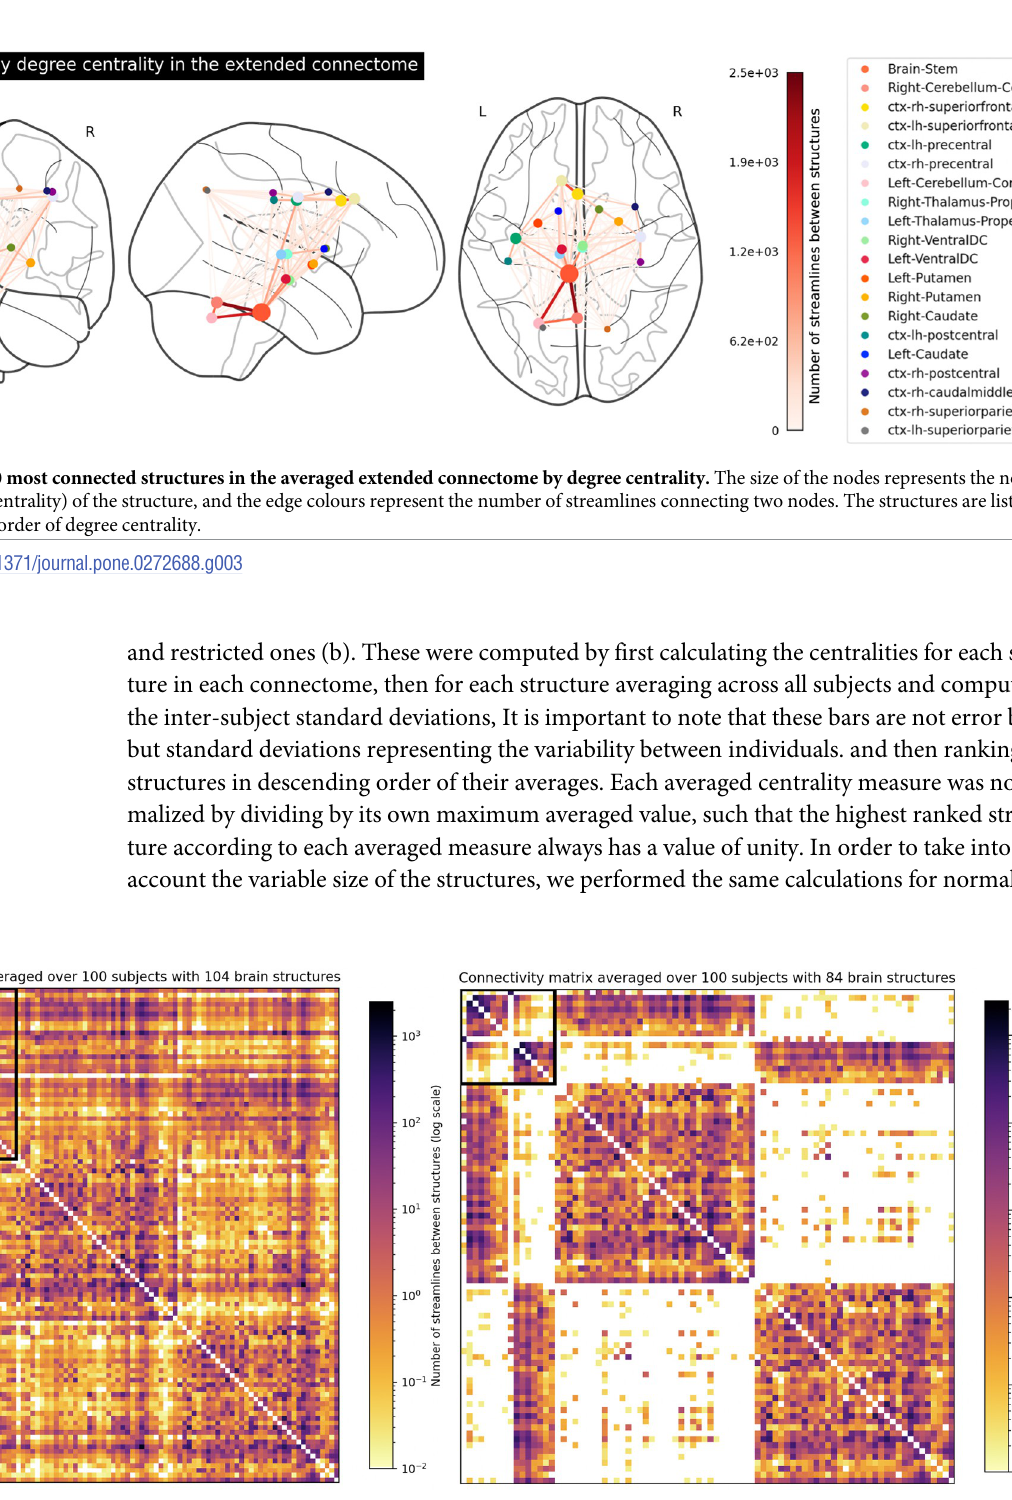
Fig 4. (a) (left) The structural connectivity matrix for the extended connectome (104 structures), averaged over 100 adult subjects; (b) (right) the structural connectivity matrix for the restricted connectome (84 structures). The black box indicates subcortical structures. The full list of structures in the extended and restricted connectomes can be found in Supporting information and S1 Table